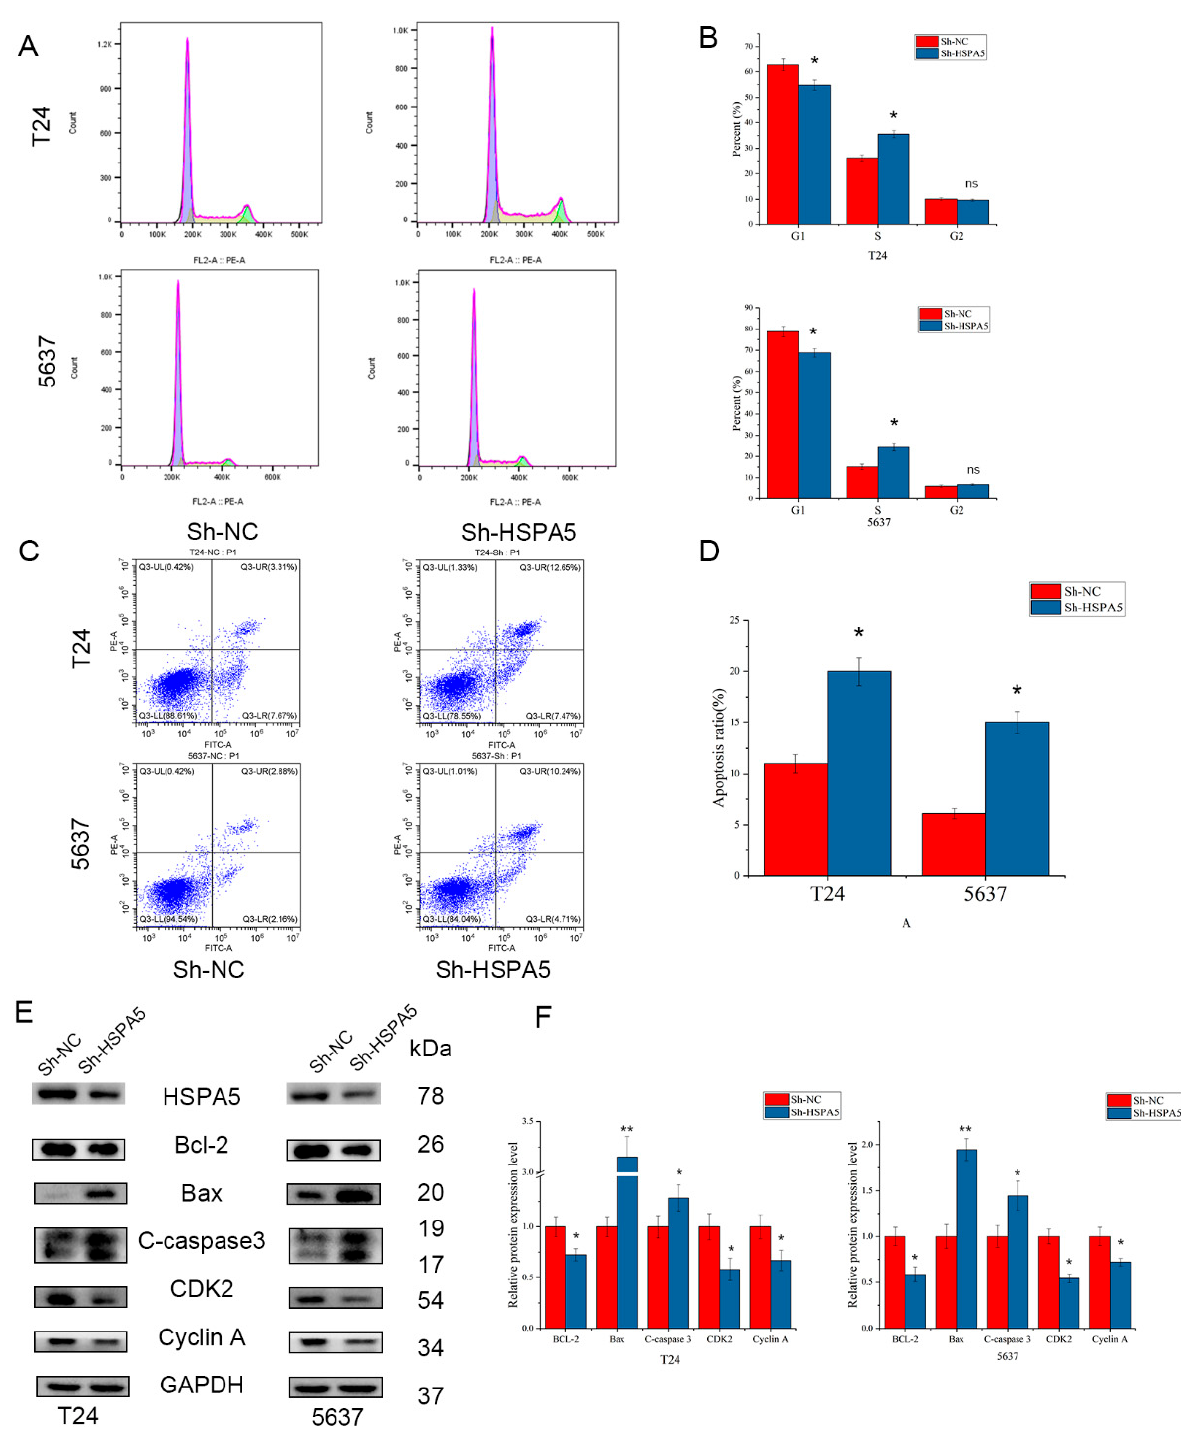
Figure 5. HSPA5 knockdown affects the cell cycle and apoptosis. ( A , B ) HSPA5 downregulation increased the percentage of S phase. ( C , D ) Low expression of HSPA5 increased cell apoptosis. ( E , F ) Western blotting verified the above results. All data are presented as the mean ± SD. * p < 0.05, ** p < 0.01.